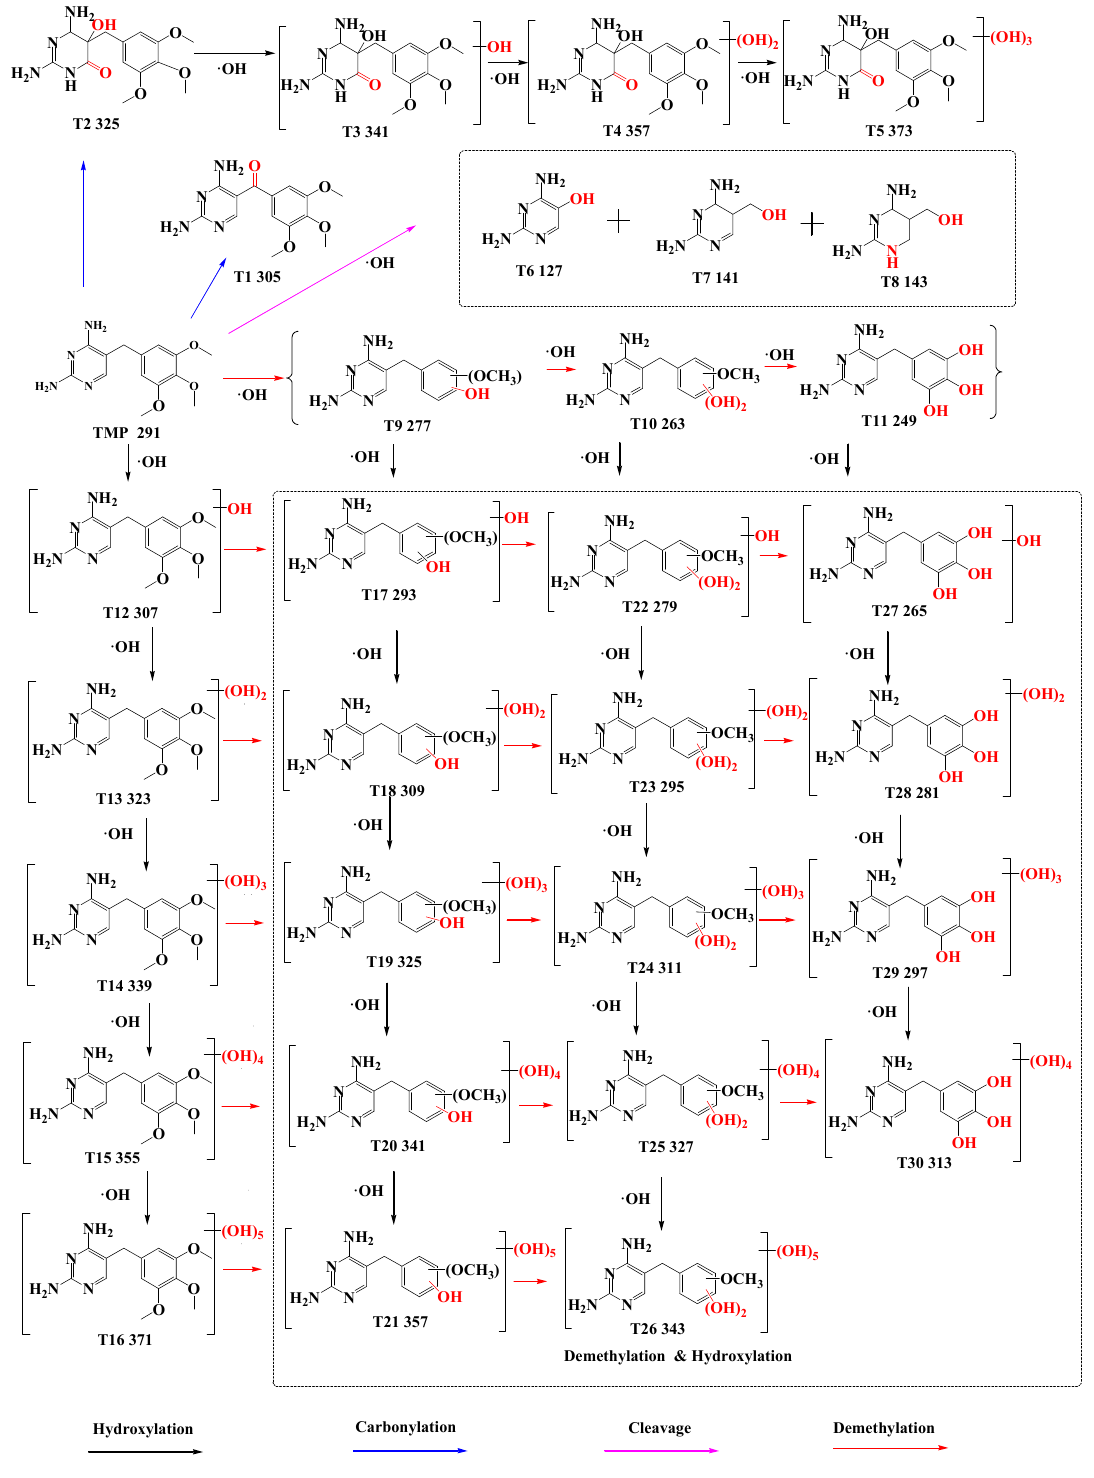
Figure 2. The intermediate products and potential pathways of TMP during ozonation.